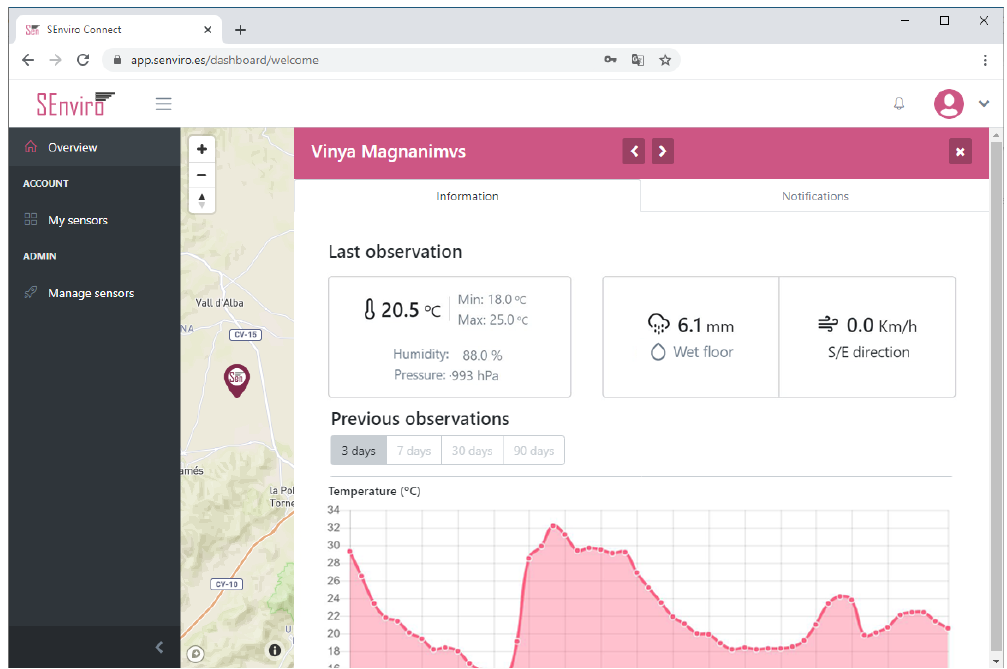
Figure 13. A screen capture of the SEnviro connect, showing the data and alerts for each IoT